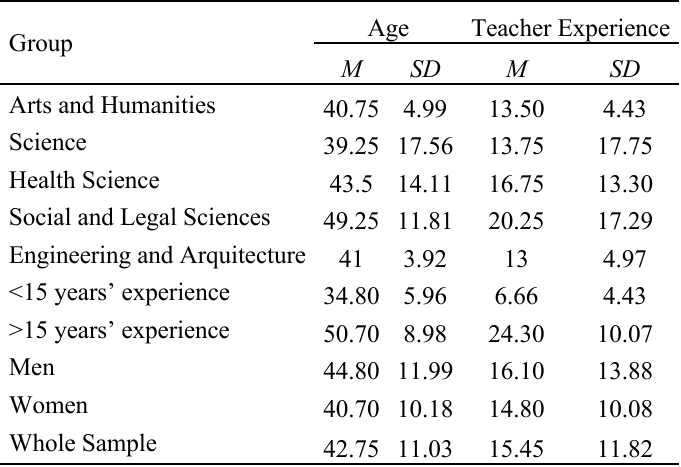
Age and teacher experience in university .